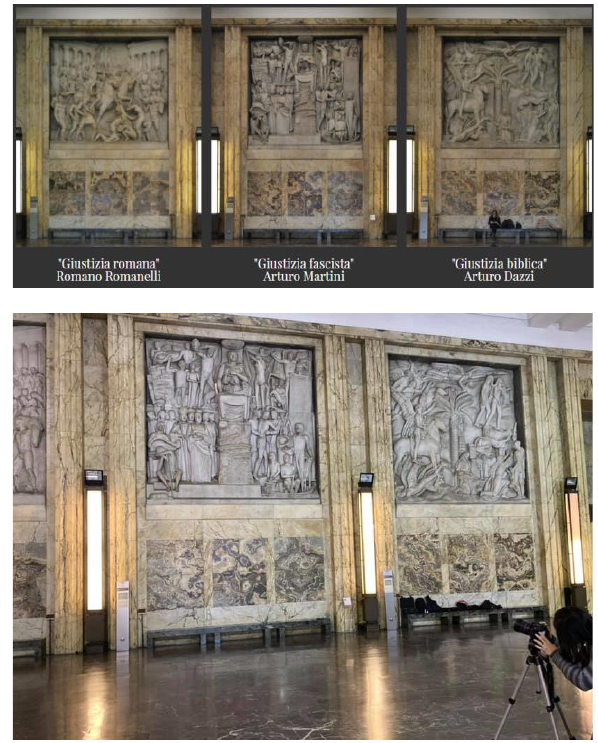
Fig. 11. Photogrammetric acquisition was carried out always using a tripod to achieve pictures with sufficient quality.